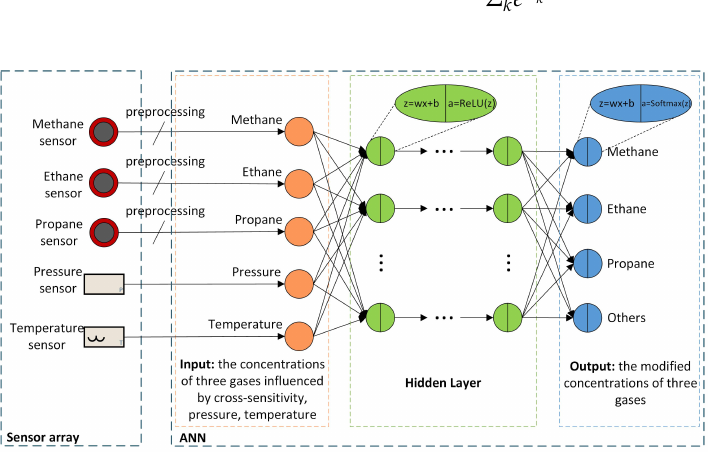
Figure 4. ANN input and the structure of the multilayer perceptron neural